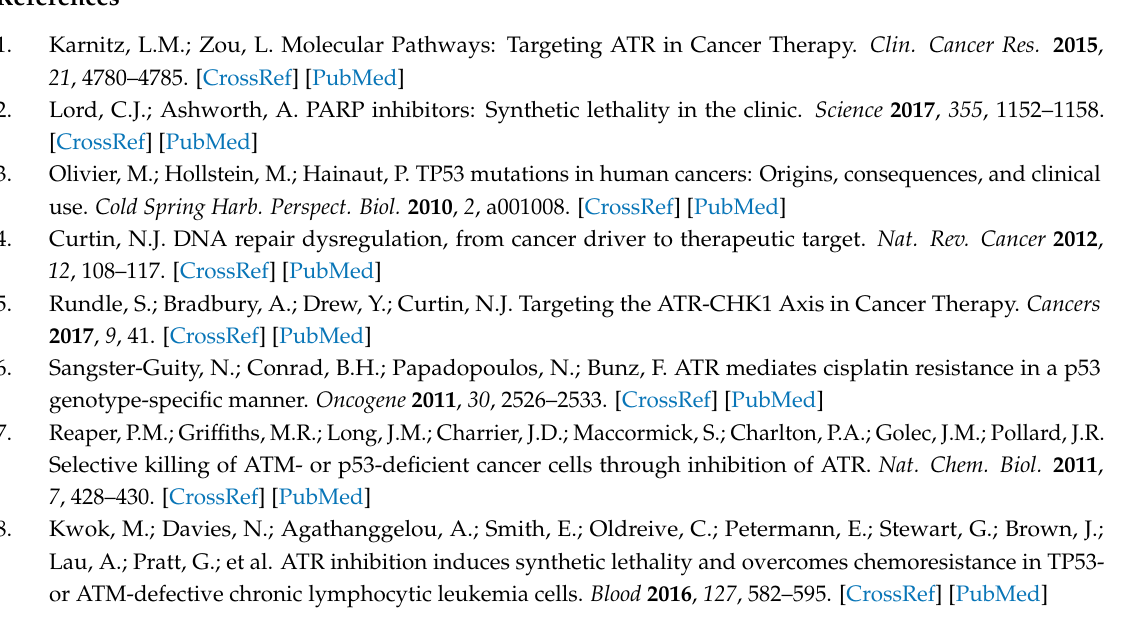
Table S1: ATR inhibition by VE-821 in the cell line panel. Table S2: VE-821 single-agent cytotoxicity. Table S3: Summarised chemosensitisation data for all cell lines. Table S4: Summarised Radiosensitisation by VE-821 in all cell